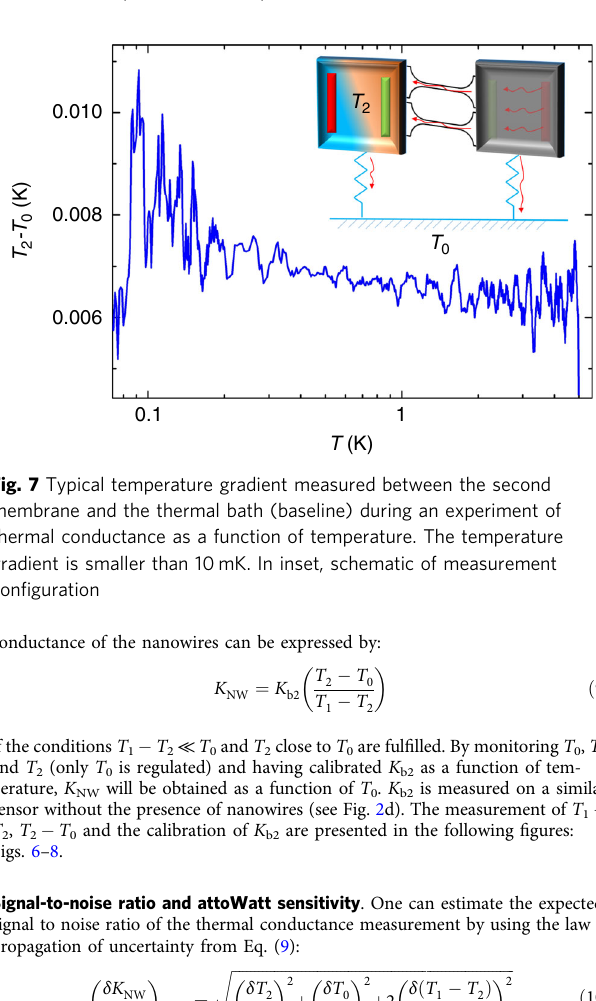
Fig. 6 Typical temperature gradient measured between the two membranes during an experiment of thermal conductance as a function of temperature. This temperature gradient is smaller than 30 mK above 200 mK. In inset, schematic of experimental set-up